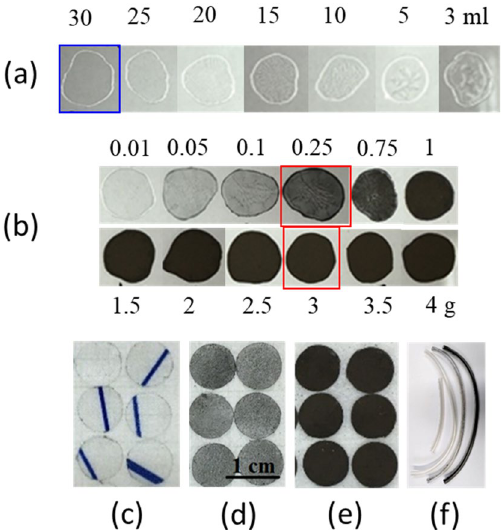
Figure 1. Coatings fabrication stages: ( a ) coatings of PVP with different concentrations (0.5 g of PVP in 3–30 ml of ethanol) on a glass substrate; ( b ) coatings of MgB 2 -PVP with different concentrations (0.01–4 g of MgB 2 introduced into a solution of 0.5 g PVP/30 ml ethanol) on a glass substrate (see text); ( c – e ) coatings on the polymer foil of the catheter reservoir of PVP foil (0.5 g PVP/30 ml ethanol), (MgB 2 -PVP) foil 0.25 (0.25 g MgB 2 /0.5 g PVP/30 ml ethanol), (MgB 2 -PVP) foil 3 (3 g MgB 2 /0.5 g PVP/30 ml ethanol), respectively; ( f ) (from left to right) pristine silicon tube of a catheter and coatings on the catheter silicon tube of PVP tube (0.5 g PVP/30 ml ethanol), (MgB 2 -PVP) tube 0.25 (0.25 g MgB 2 /0.5 g PVP/30 ml ethanol), (MgB 2 -PVP) tube 3 (3 g MgB 2 /0.5 g PVP/30 ml